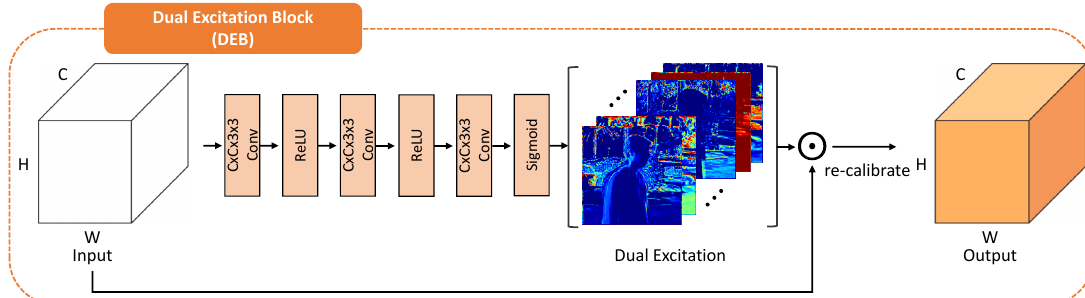
Figure 5. Illustration of dual excitation block (DEB), which outputs dual excitations. Fused features are recalibrated both spatially and channel-wise to highlight the meaningful features and exclude harmful features caused by alignment error or